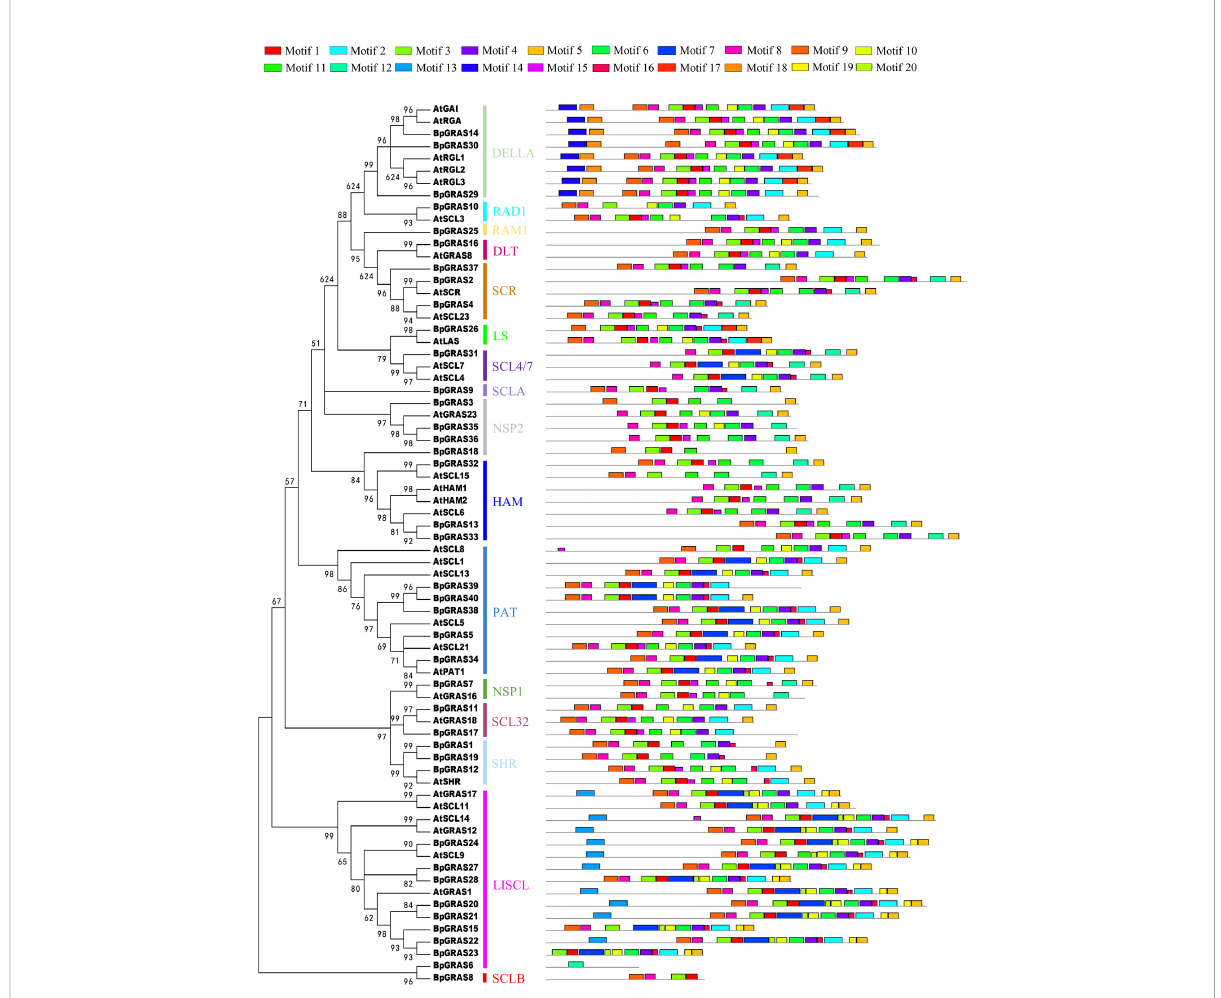
FIGURE 3 Putative motifs in each GRAS protein from birch and Arabidopsis. Schematic representation of the conserved motifs elucidated by MEME. Each motif is represented by a number in the colored box. The black lines represent non-conserved